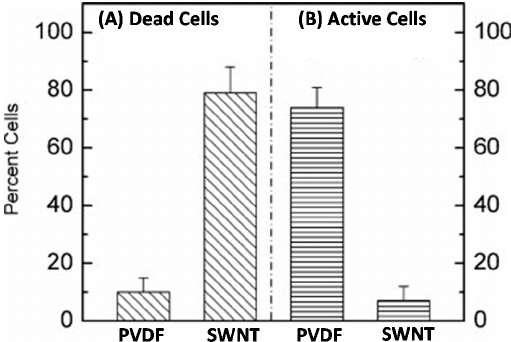
Figure 6. Inactivation and metabolic activity of E. coli cells retained on a SWNT/poly(vinylidene fluoride) (PVDF) composite filter and on a bare PVDF membrane filter: ( A ) Inactivation test results showing the presence of E. coli cells that are not viable; ( B ) metabolic activity test results indicating the presence of metabolically active E. coli cells. Adapted with permission from Reference [16].